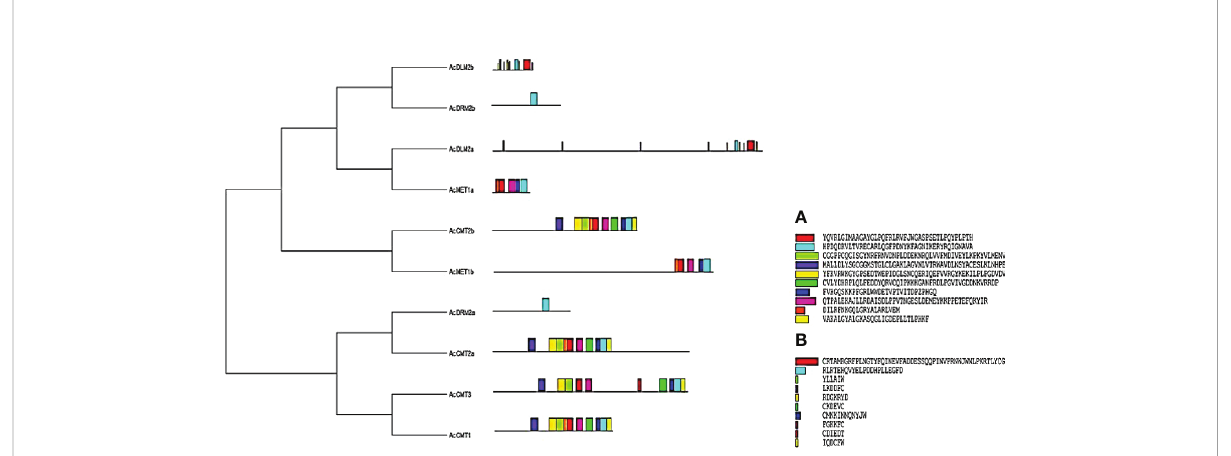
FIGURE 2 Evolutionary analysis and conserved motifs identi fi ed in A. cruentus C5-MTase and DMTase proteins; evolutionary analysis was performed using the Neighbor-Joining method; conserved motifs were identi fi ed using the MEME software, conserved motifs identi fi ed in (A) C5-MTases and (B)